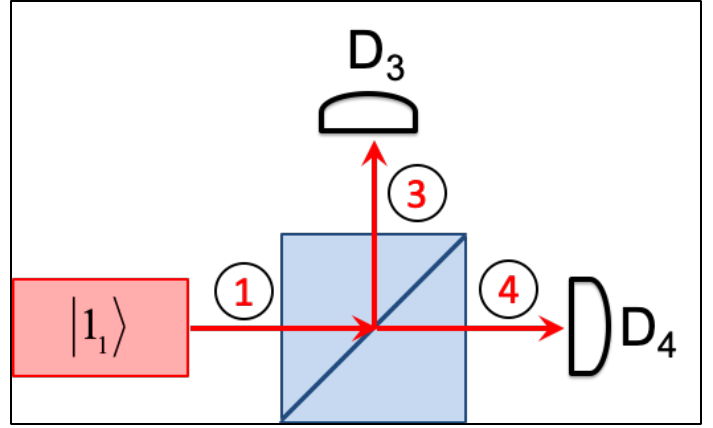
Figure A4. The optical beam splitter. |1 1 (cid:105) describes the Fock state at the entrance mode of the beam splitter. See Figure 2a for more details.